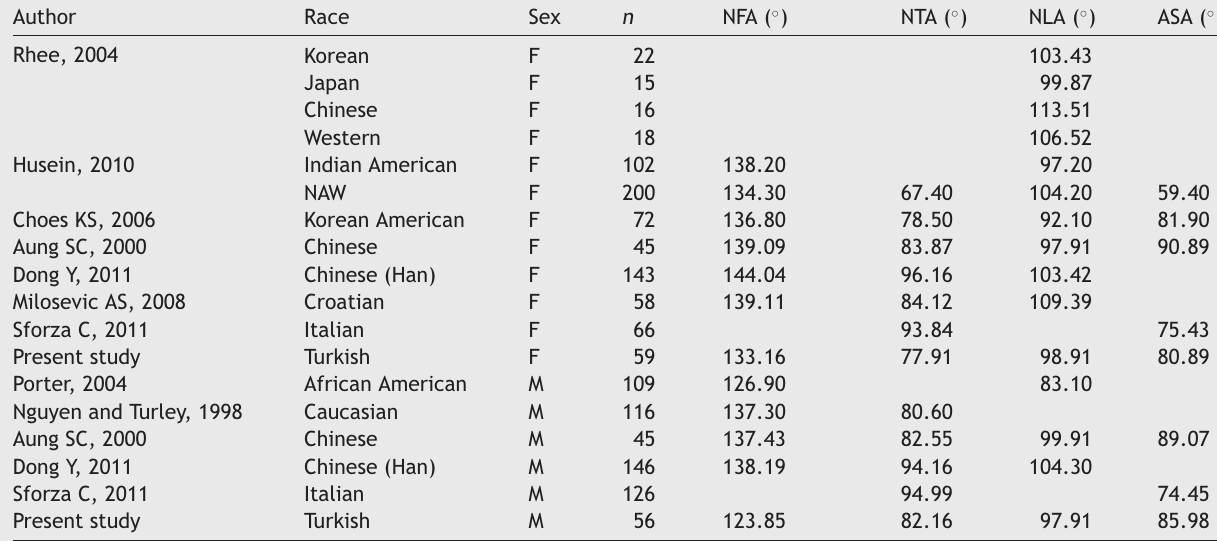
Comparison of nasal angles of females and males in the present study and other